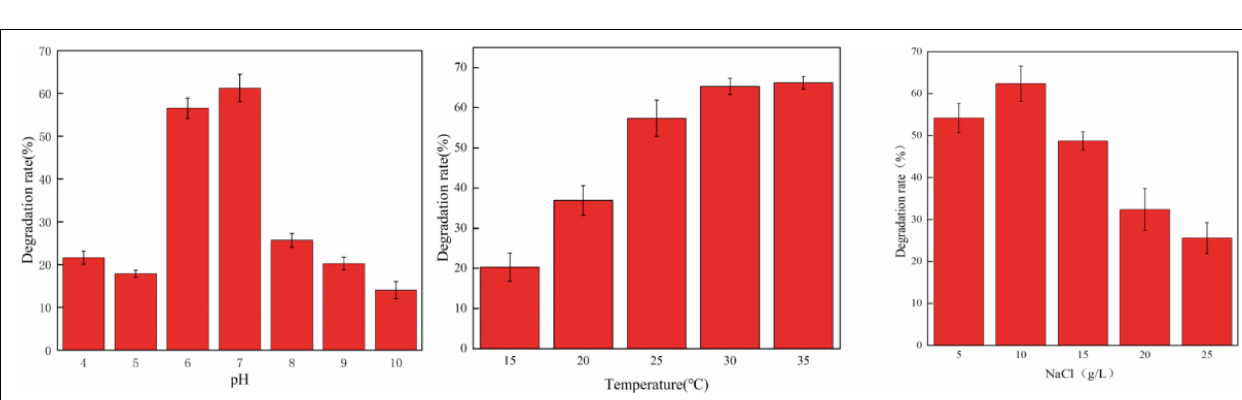
antibiotics such as chlortetracycline (CT), oxytetracycline